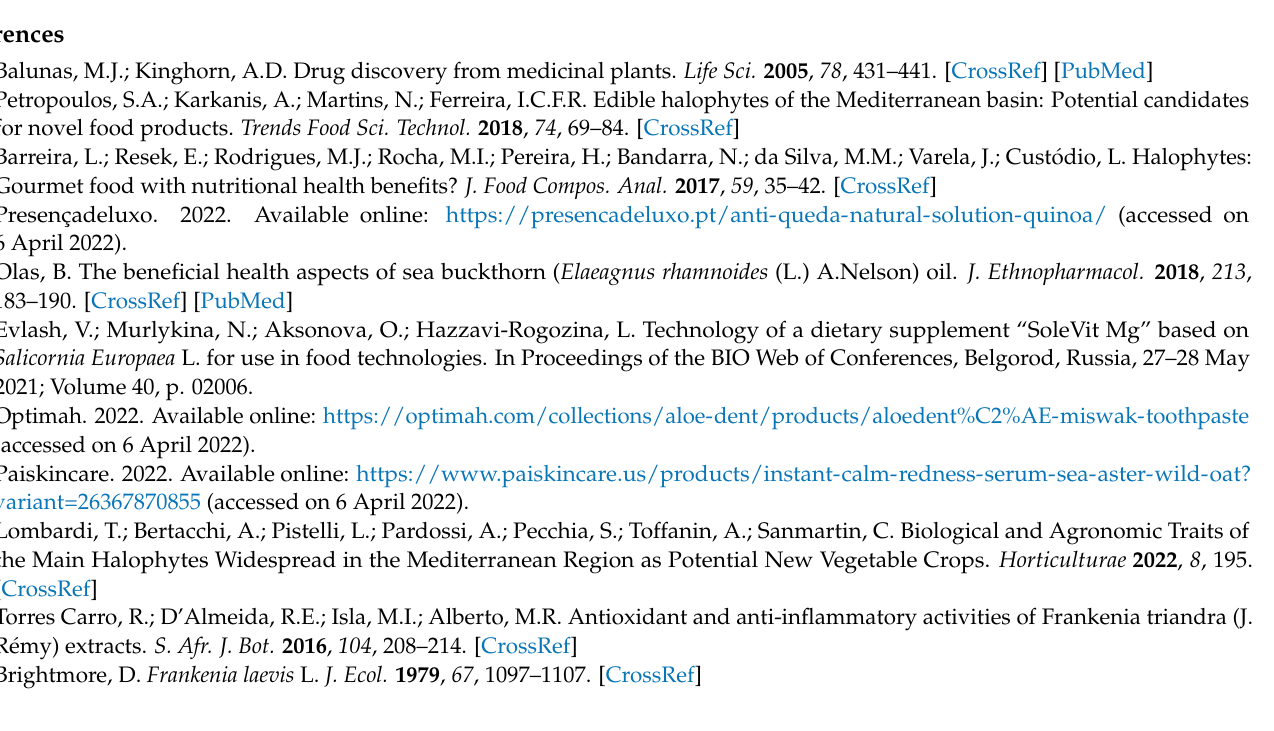
extract. Figure S2: Total ion chromatogram (negative mode) of F. laevis methanol extract. Figure S3: Total ion chromatogram (positive mode) of F. laevis dichloromethane extract. Figure S4: Total ion chromatogram (negative mode) of F. laevis dichloromethane